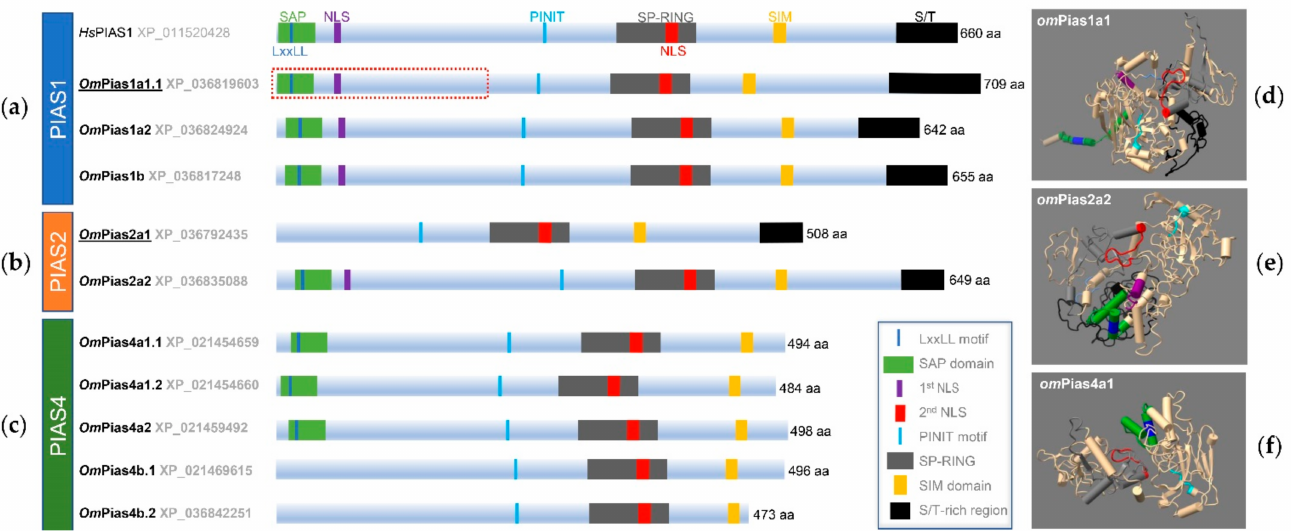
Figure 4. Representation of the domains and motifs characteristic of the variants of ( a ) Pias1, ( b ) Pias2, and ( c ) Pias4 in rainbow trout (Om). A schematic structure of the human (Hs) PIAS1 protein is included. The tertiary structures of ( d ) Pias1a1, ( e ) Pias2a2, and ( f ) Pias4a1 from rainbow trout were drawn using UCSF ChimeraX. The domains and motifs ( a – f ) are labelled according to the legend to the right of the Pias4 structures. The two underlined Pias variants were overexpressed in a cell model; the segment framed in red was overexpressed as a third ‘truncated Pias1 (cid:48)